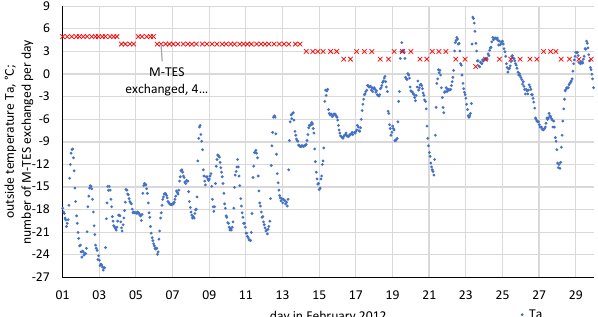
Figure 10. Outside temperature (Ta) in Zakopane and number of M-TES exchanges ( × ) calculated for February 2012. Source: own study, based on [63].